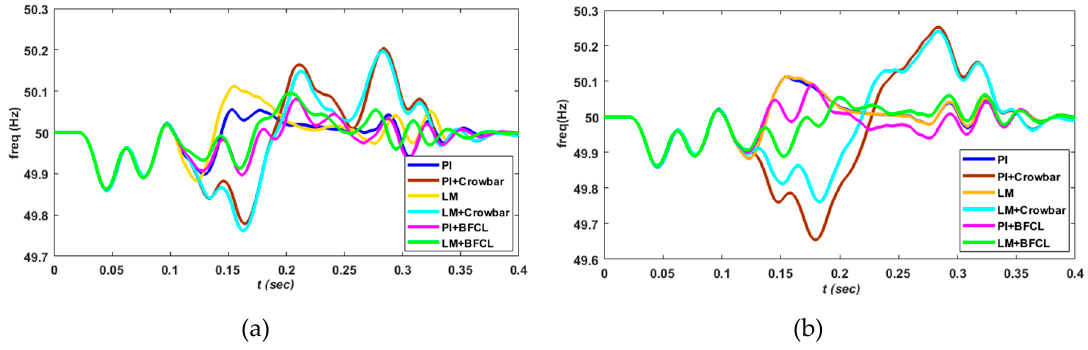
Figure 18. Frequency variations in PCC during the P-G fault 18( a ) and P-P fault 18( b ).